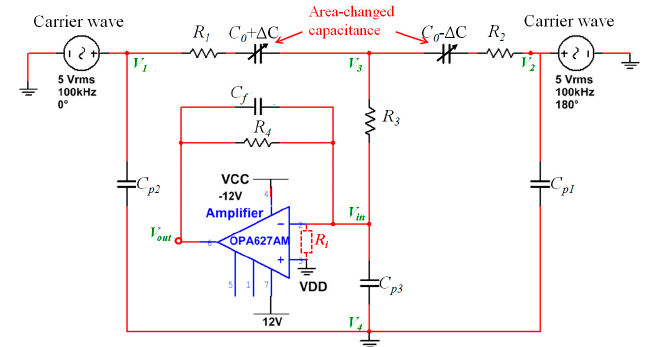
Figure 2. Model of the transducer including parasitic capacitance, where C 0 + Δ C and C 0 - Δ C are the differential area-changed capacitances, C p 1 and C p 2 are the parasitic capacitances of the electrodes on the top die, C p 3 is the parasitic capacitance between the electrodes on the proof mass and silicon substrate, and R 1 , R 2 and R 3 are the resistances of the deposited wires for signal transmission, C f and R 4 are the electron devices of the amplifier circuit. The silicon substrate connects to the ground through ohmic contact to overcome influences of C p 1 and C p 2 on the sensitivity and offset.